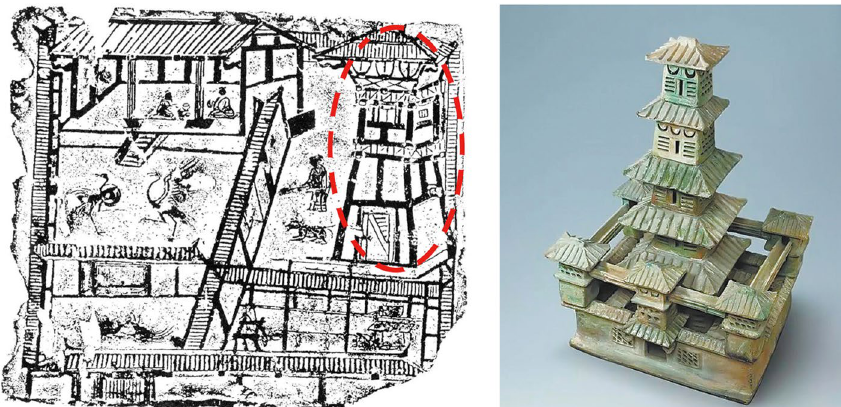
Fig. 2 Left: architectural picture of an ancient watchtower in Eastern Han Dynasty tomb portrait bricks in Chengdu (Source: http:// www. mrjjxw. com/ artic les/ 2019- 07- 23/ 13566 43. html). Right: a pottery five-layer green glazed watchtower unearthed from Han tombs in Wuwei, Gansu Province (Source: Official website of National Museum of China)